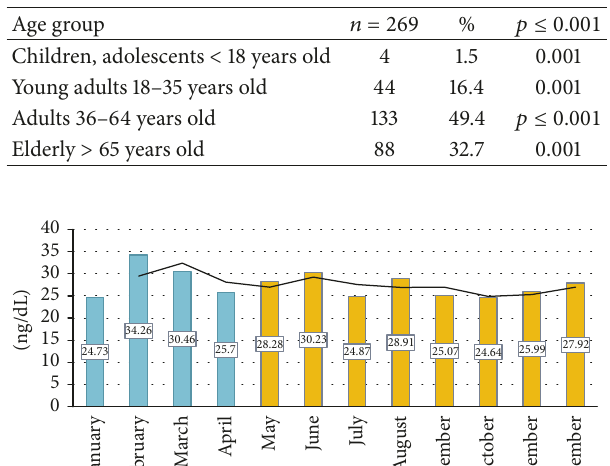
Men had higher levels of 25 (OH)-D than women, but levels in both sexes were deficient with a mean of 27.01 ± 9.72 and 28.89 ± 12.18,